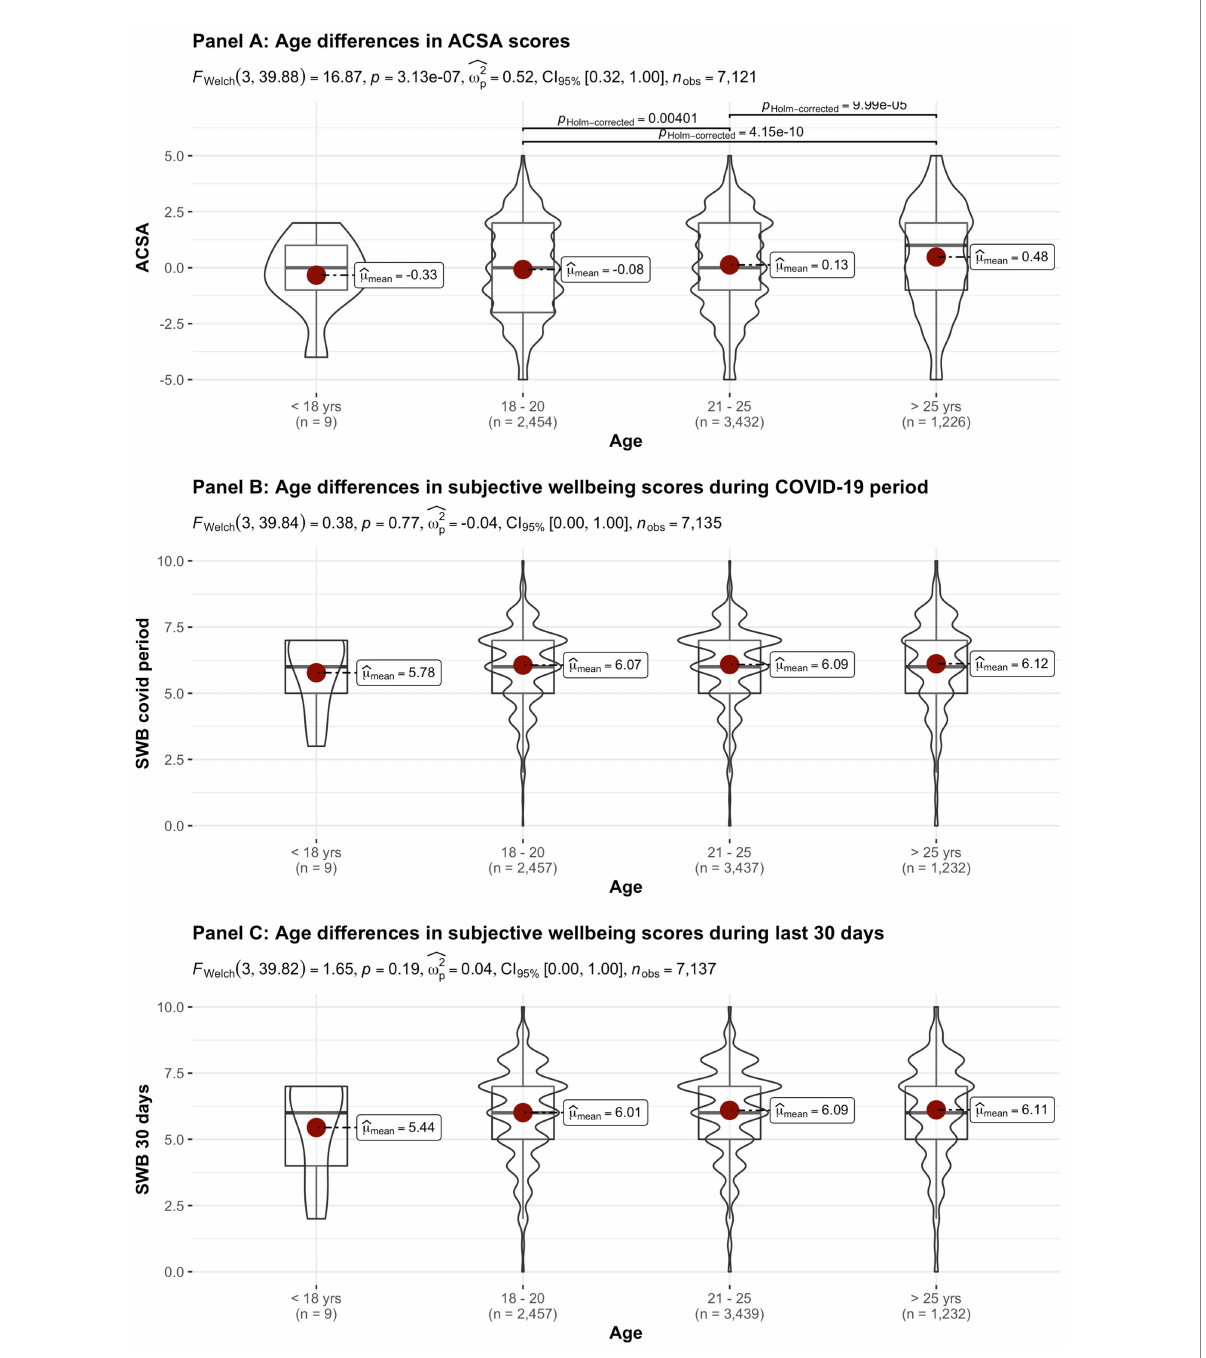
FIGURE 3 Mean ACSA (during the last 2 weeks, on a − 5 to +5 scale) and SWB-scores (during the COVID-19 period, and during the past 30 days, both on a 0–10 scale) comparing student groups during COVID-19 in terms of